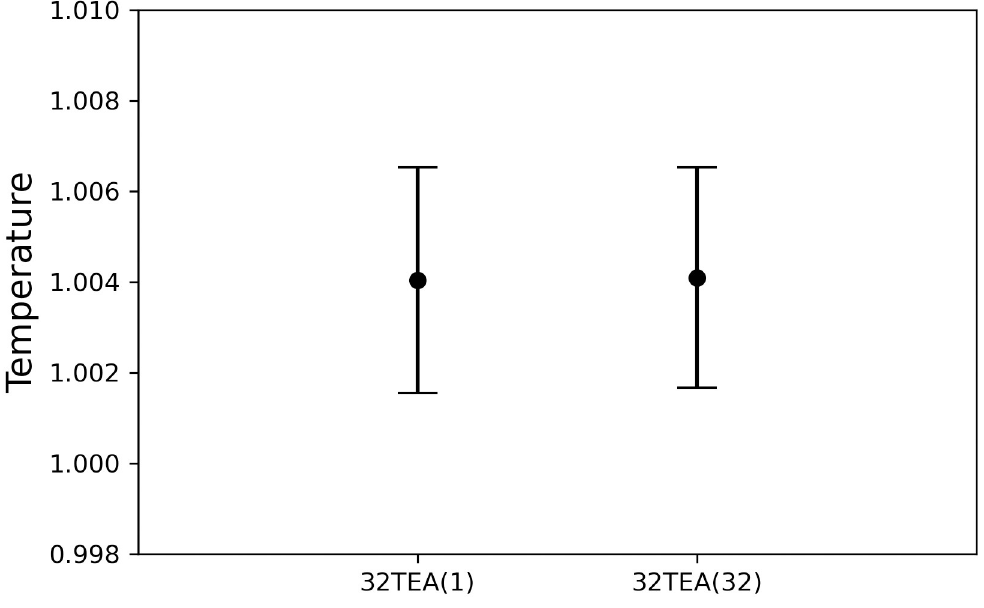
Fig 7. Temperature of the membrane